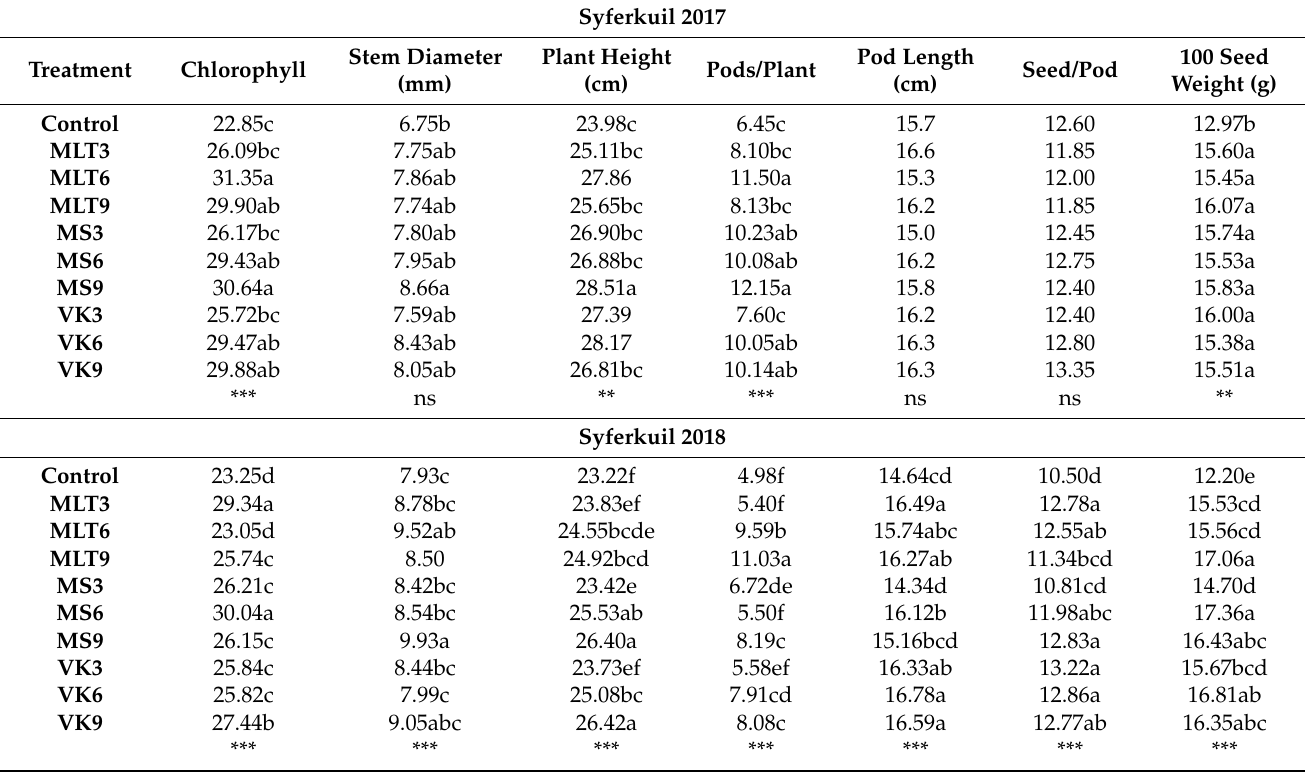
Table S1). In the 2017 season, differences were observed mainly between the control and mulching rates of more than 6 t/ha, regardless of the mulch type. Moringa stems at 9 t/ha had 34% higher chlorophyll content compared to the control. In the 2018 season, the control treatment also had lower chlorophyll content compared to the mulched treatments. There were also variations observed between the mulch types in the two seasons. For instance, MLT6 showed higher chlorophyll content compared to VK3. Differences in the effect of the mulch type were also observed for plant height and pods per plant. In the 2017 season, the pod length and the number of seeds per pod did not differ, while for 100 seed weight, the control had the lowest weight of 12.97 g compared to the other treatments. In the 2018 season, both the pod length and number of seeds per pod differed between the treatments. Higher pod lengths were observed in Vachelia karroo mulches and moringa leaves and twigs and lower pod lengths in the control and moringa stems. Table 5. Yield determining parameters as influenced by the combined effect of mulch type and rates at